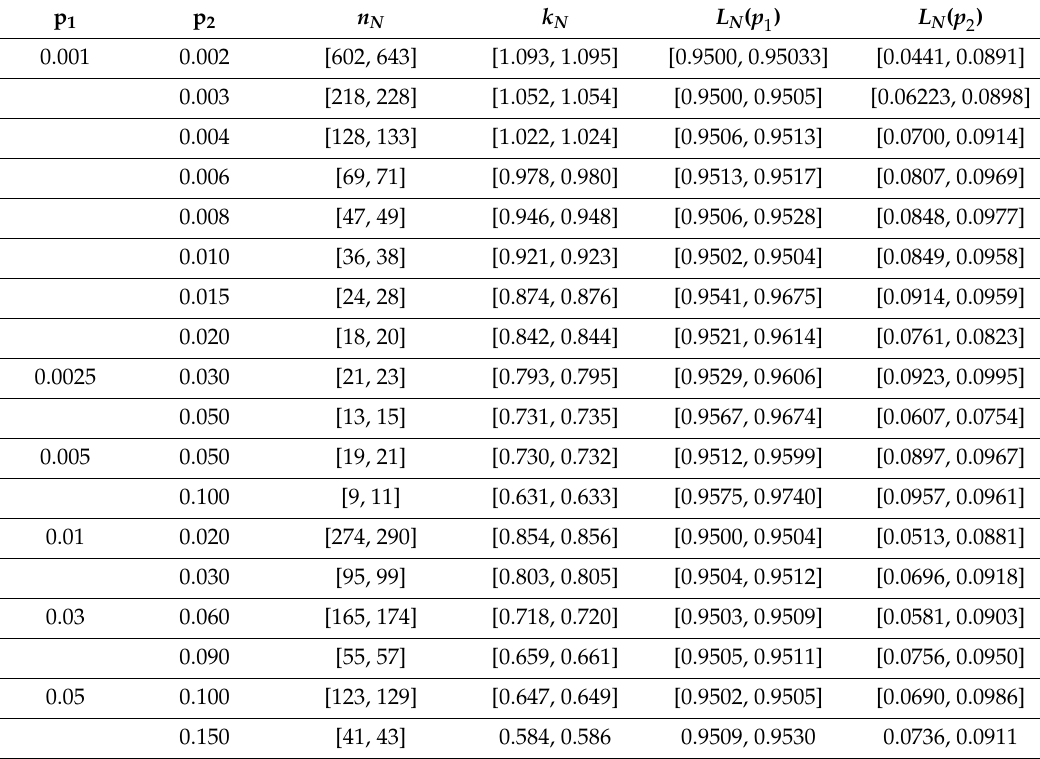
Table 1. The plan parameters of the plan when α = 0.05 , β = 0.10 .